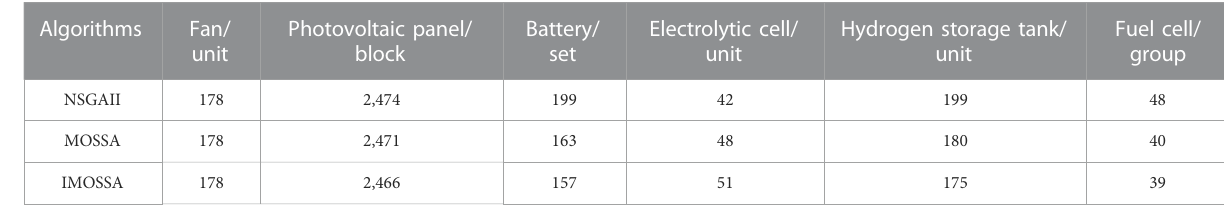
TABLE 3 Capacity con fi guration schemes of three algorithms.